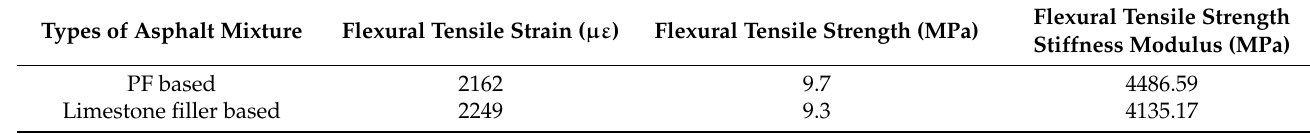
Table 10. Low-temperature flexural performance results.